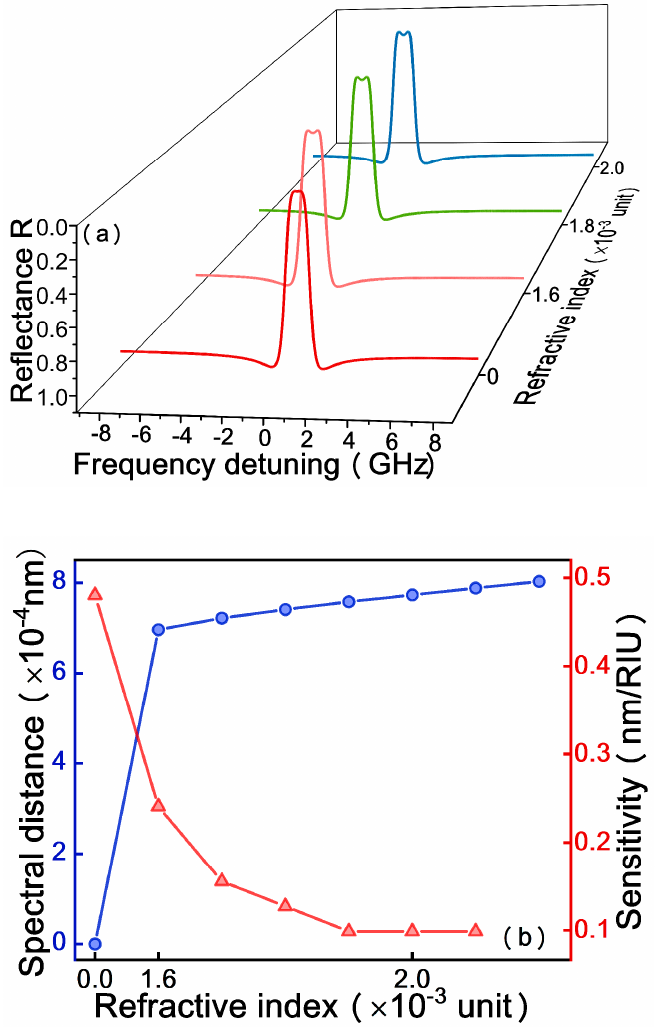
Figure 8. The influence of the refractive index(RI) of the coupling layer on the reflectance spectrum ( a ) and spectral distance (blue line) and sensitivity (red line) ( b ).